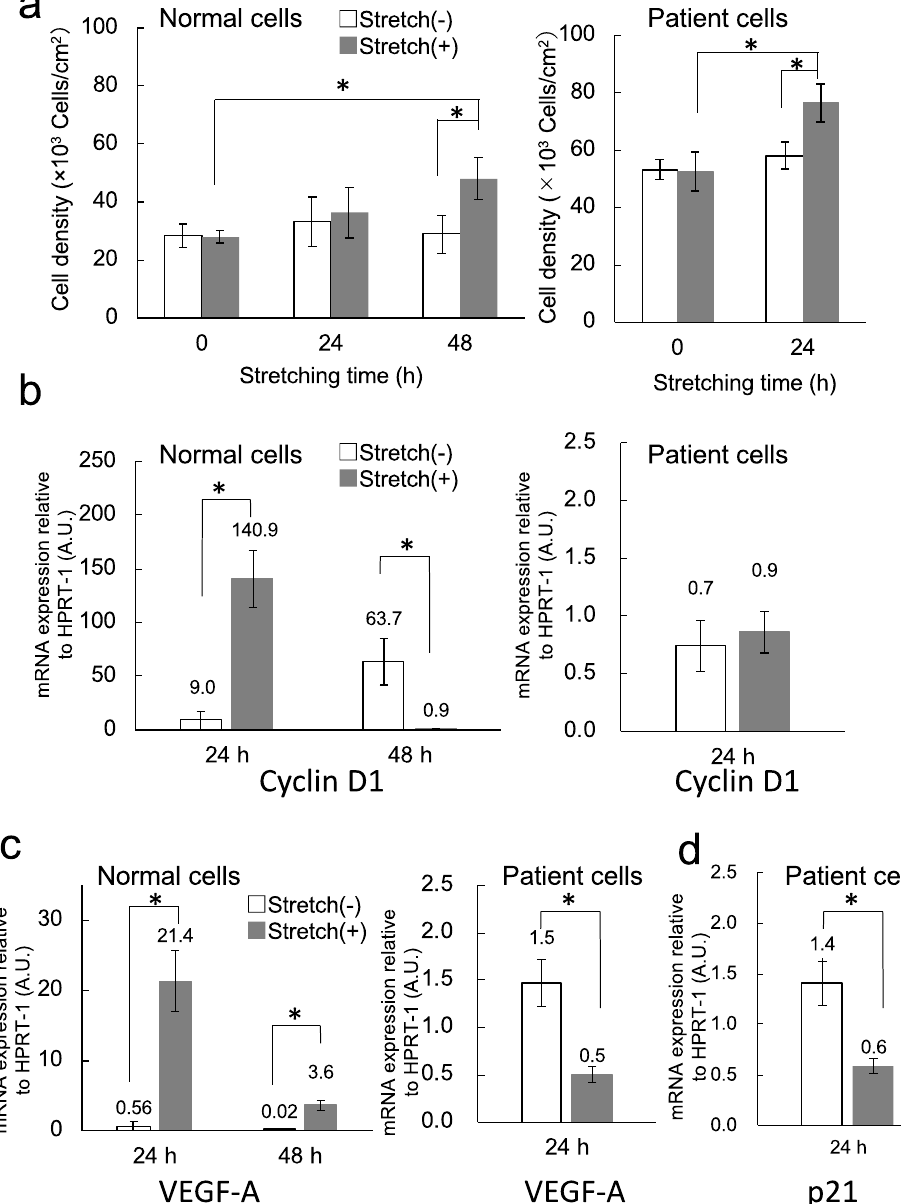
Figure 4. Effects of cyclic stretch on cell proliferation. ( a ) Cell proliferation. Data are shown as mean ± standard deviation (SD) of three images (500 µ m × 500 µ m). * p < 0.05 (unpaired two-tailed Student’s t test). Gene transcription of ( b ) Cyclin D1 , ( c ) VEGF-A, and ( d ) p21 in cells cultured in the microchannel. mRNA levels were quantified by real-time PCR. HPRT1 was used as a control gene. Data are shown as means ± SD ( n = 3).